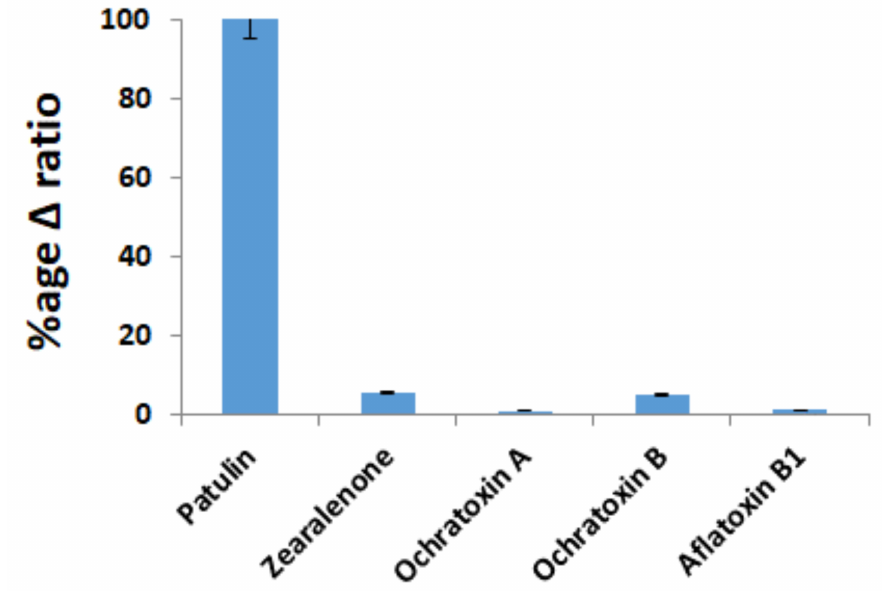
Figure 4. Selectivity test for the developed